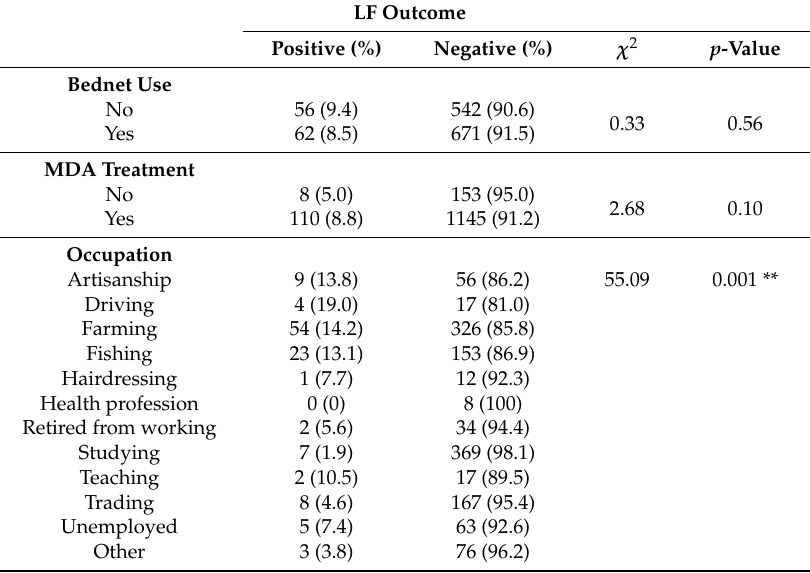
Table 3. Bivariate analysis of factors associated with lymphatic filariasis. ** p <